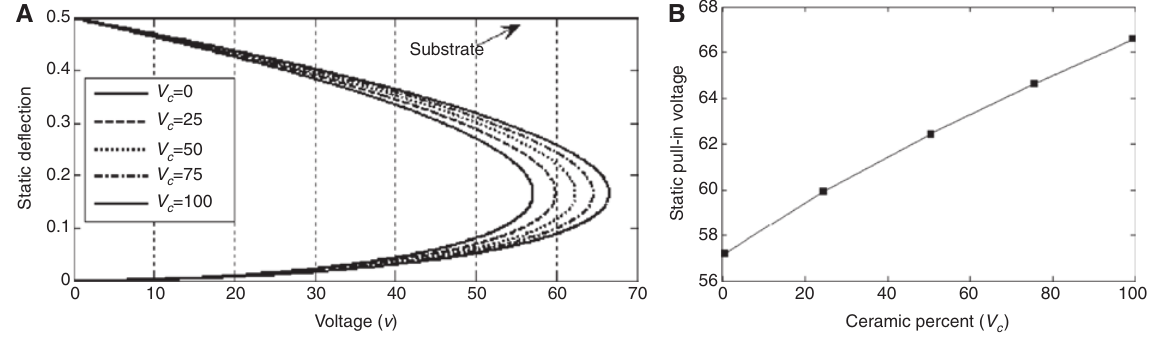
Figure 2 (A) Deflection of the microgripper beam free ends against the voltage for different ceramic volumes and (B) variation of the micro- gripper static pull-in voltage against the ceramic volume.